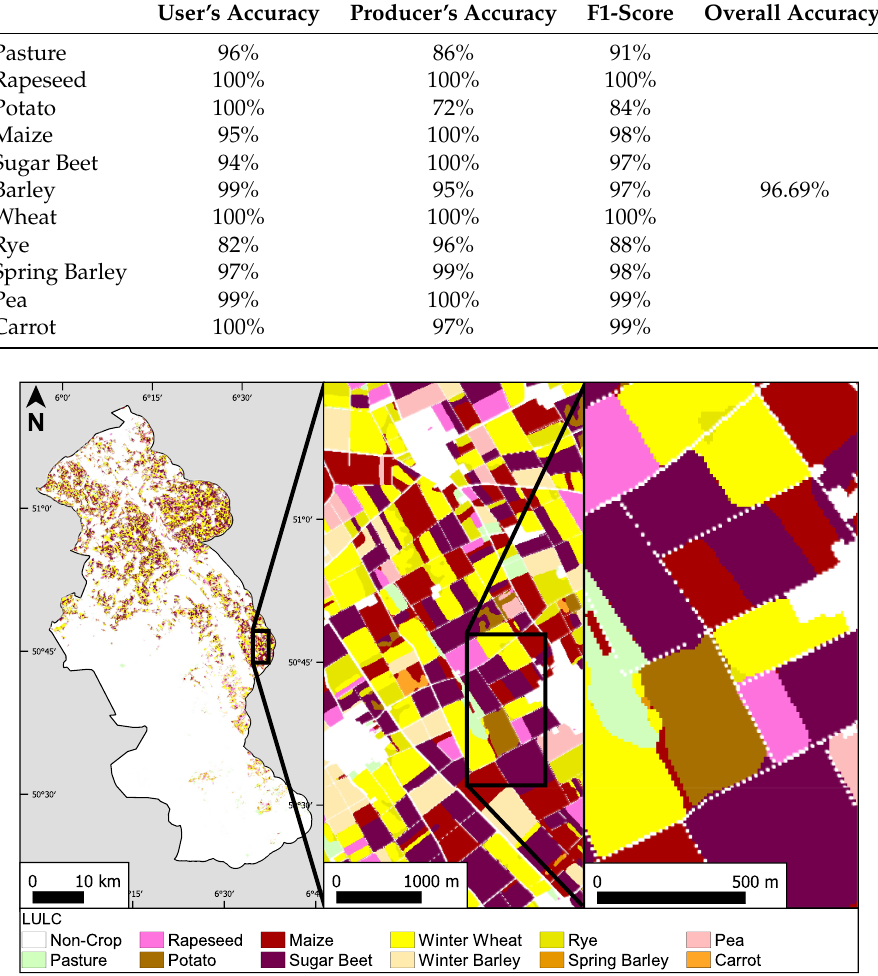
Table 5. Accuracy measures of the proposed classification, shown in Figure 3.